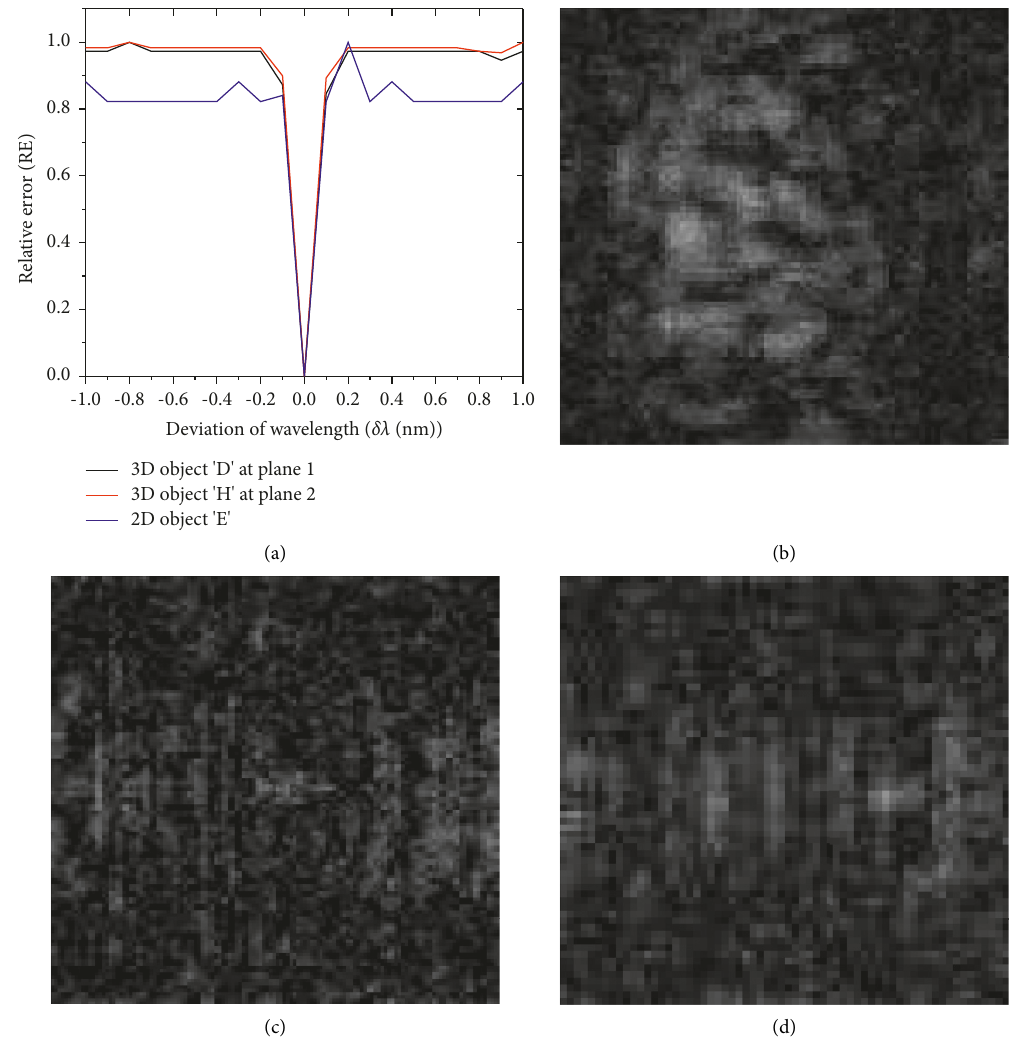
Figure 18: Decrypted results with wrong wavelength: (a) the RE plot corresponding to the deviation of wavelength; (b) reconstructed 2D object with wrong wavelength λ � 632 . 81 nm; (c), (d) reconstructed 3D complex object with wavelength λ � 632 . 81 nm at first plane and second plane,